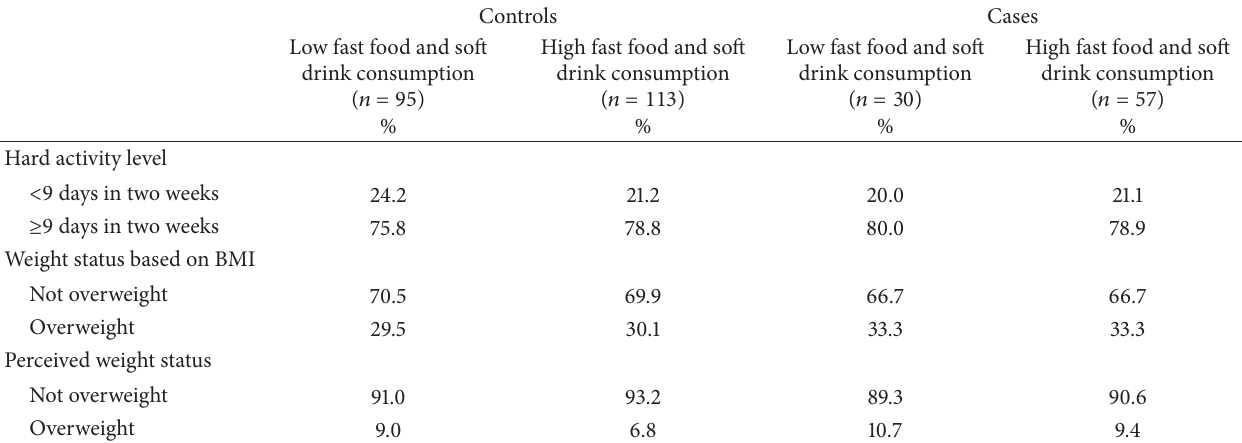
Table 3: Interrelationship between fast food and soft drink consumption, weight status, and activity level by case-control status ∗ .